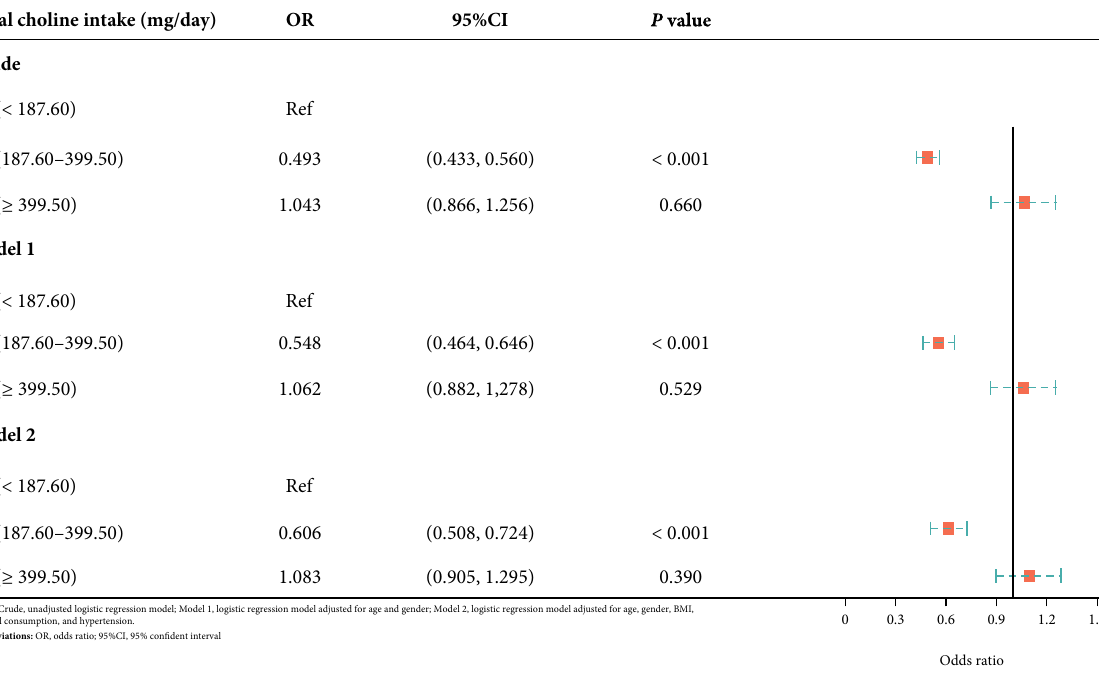
Figure 3: Forest plot-association between choline intake and cognitive performance assessed by the AF test. Table 4: The association between choline intake and cognitive performance assessed by the DSST.